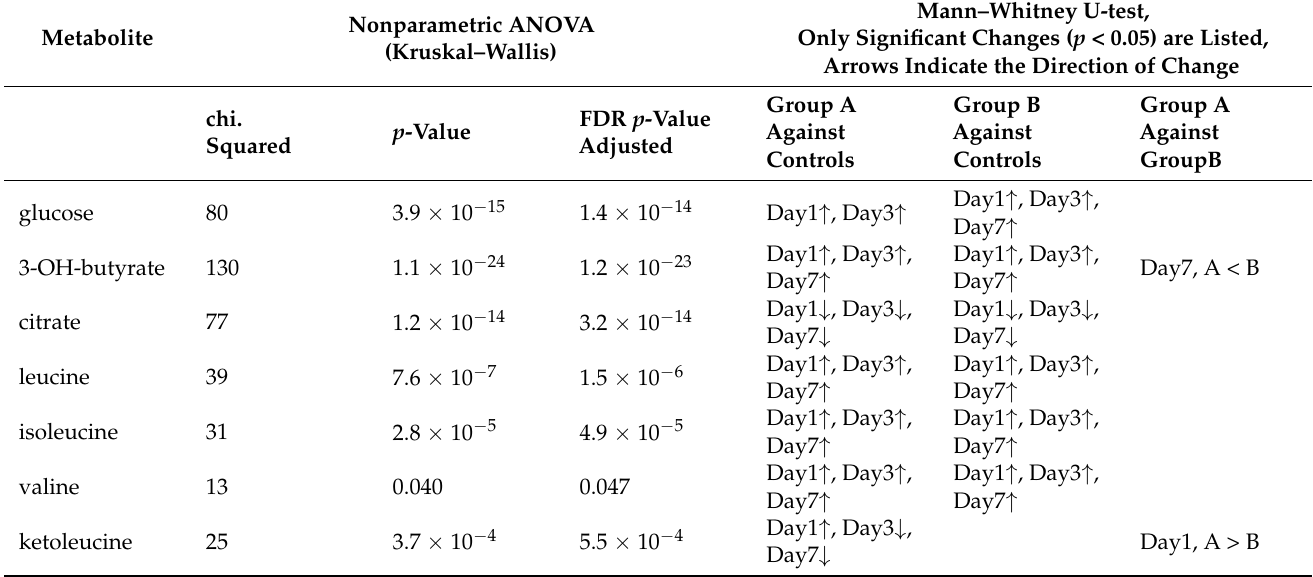
Table 4. Results from statistical tests; p -value derived from nonparametric ANOVA and Mann–Whitney U-test.